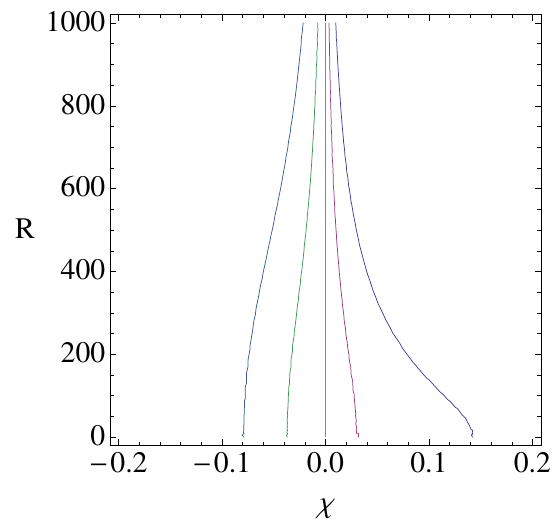
, 100, and 50 (right) in 2 (cid:25)